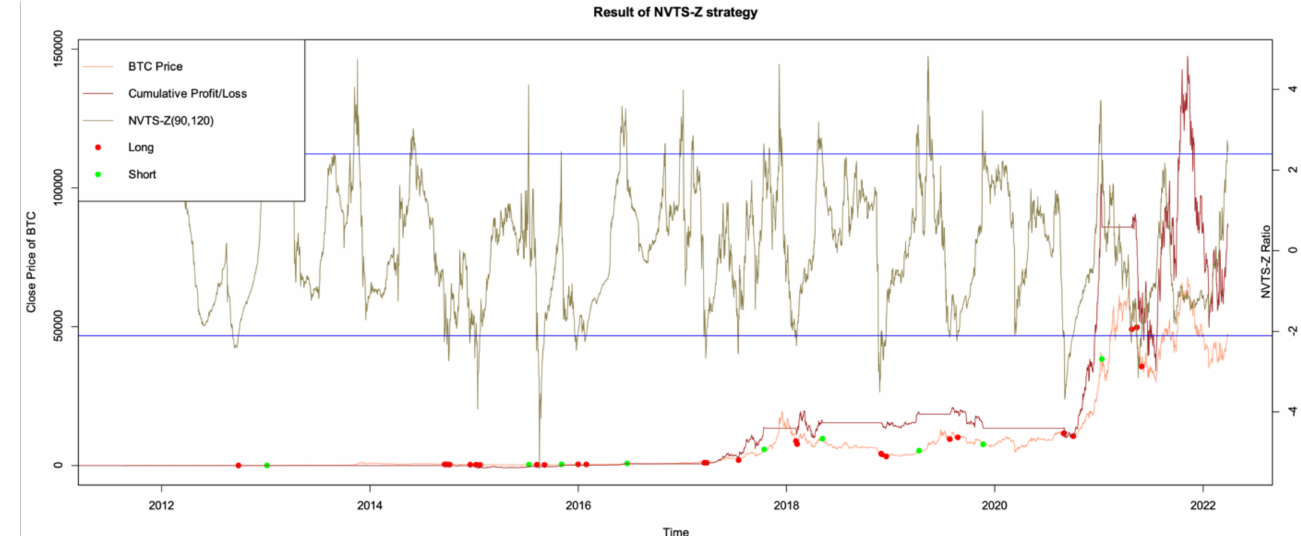
Figure A1. NVTS-Z strategy: BTC price (orange line, left-hand side), cumulative profit/loss (red line, left-hand side), NVTS -Z ratio (brown line, right-hand side), long and short thresholds (blue lines, right-hand side), long orders (red points), and short orders (green points).